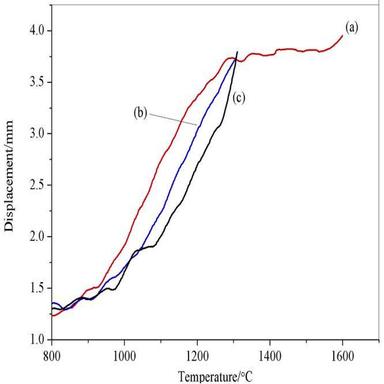
Sintering kinetics curve of FGMs Ta10W-YSZ. (a)shrinkage of TY-6-1, (b)shrinkage of TY-3-1, (c)shrinkage of TY-3-2.